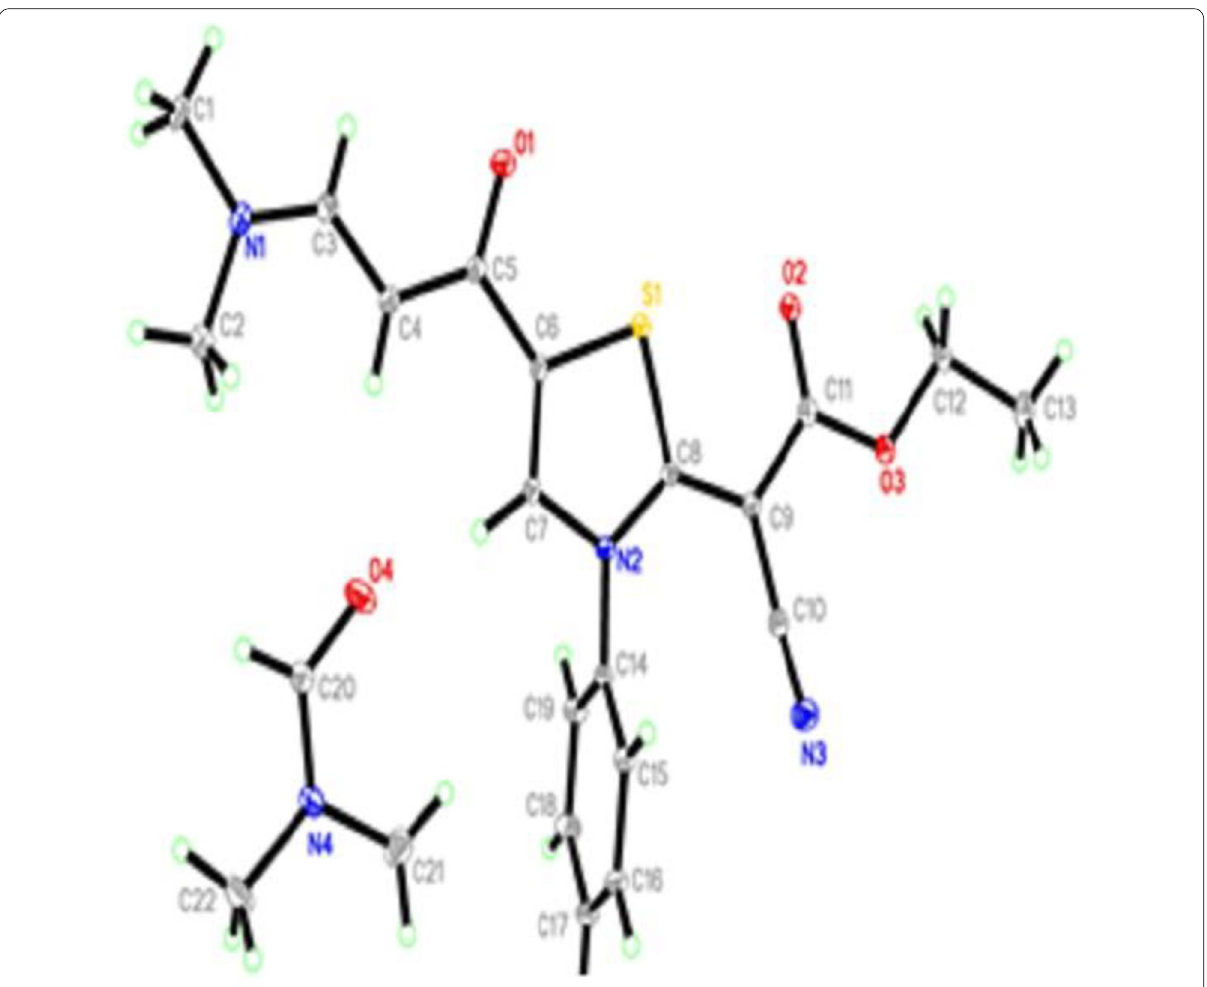
Fig. 3 ORTEP diagram of thiazole 11 . Displacement ellipsoids are plotted at the 40% probability level for non‑H